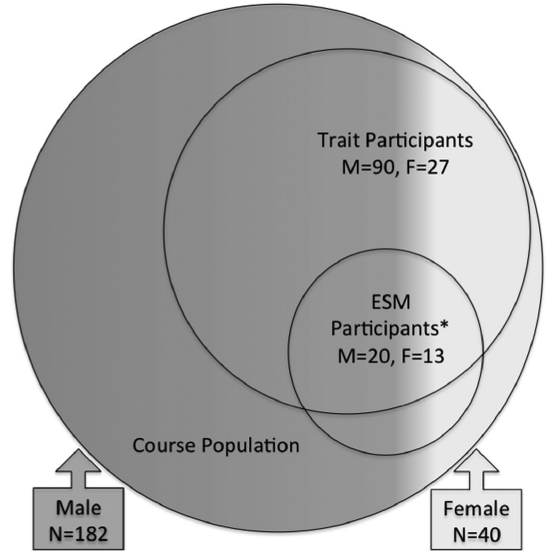
FIG. 3. Diagram of the overlapping ESM participants and trait participants. * Eight male and five female ESM participants were not trait